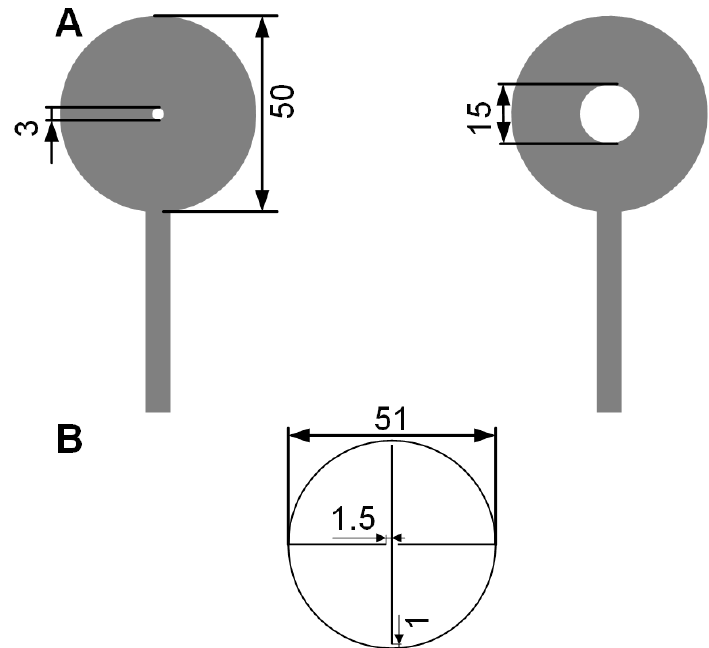
Figure 4. Design parameters for the DEA driven breathability control device: ( A ) Textile electrode design and parameters. ( B ) Circular auxetic structure design and parameters.